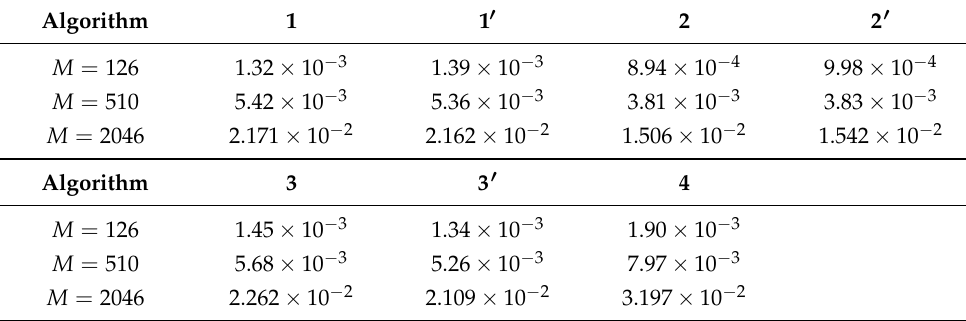
Table 2. Mean execution times (seconds) of 1000 applications of the seven algorithms for computing coefficients of a linear combination of T (cid:63) n